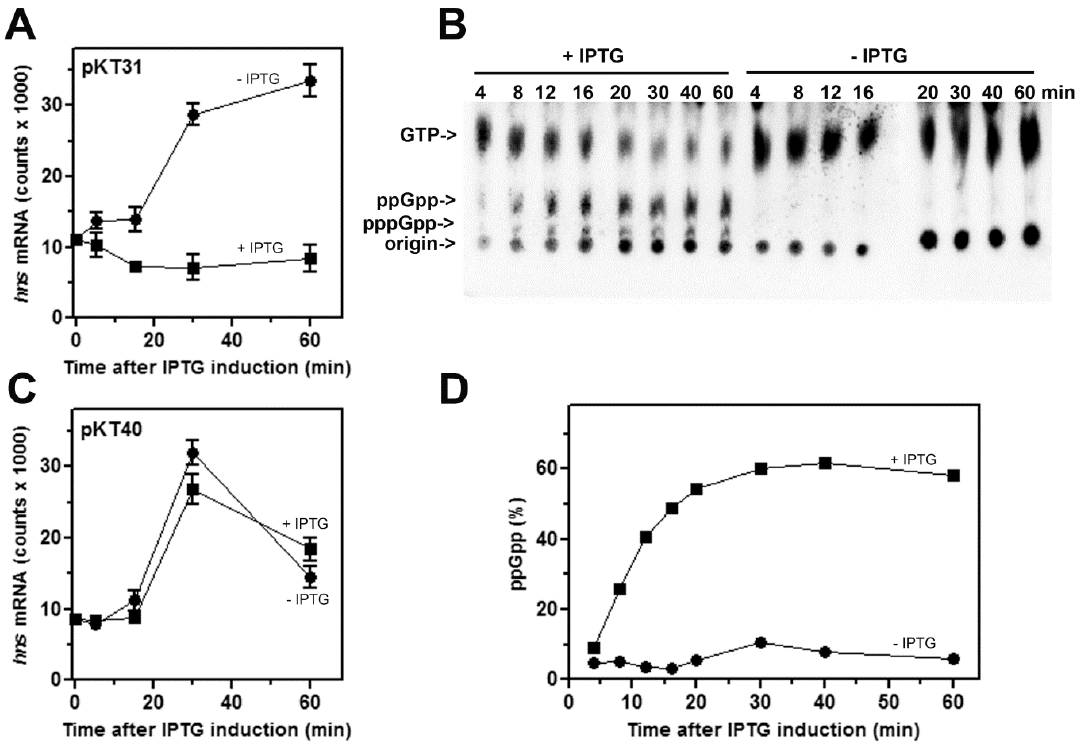
Figure 3. High levels of (p)ppGpp inhibit hns transcription in vivo. The level of hns transcript was monitored during growth in Phosphates-free medium at 37 °C in E. coli cells (KT793) expressing ( A ) or not ( C ) an active RelA synthetase. RNA to be subjected to northern blotting analysis was extracted from cells in stationary phase (time, 0; Abs 600 nm ≅ 3.0) and at the indicated times after a 10-fold dilution of cultures with fresh medium alone ( ● ) or supplemented with 400 µM IPTG ( ■ ) to activate the lacUV5::relA gene. [ 32 P]-labeled pppGpp, ppGpp and GTP, in IPTG-induced and not-induced pKT31 transformants, were resolved by thin layer chromatography ( B ) and radioactivity quantified by Molecular Imager. ppGpp, was expressed as percentage (%) of the total guanine nucleotides ( D ). The (p)ppGpp accumulation was not observed in IPTG-induced cells harboring plasmid pKT40 (not shown).